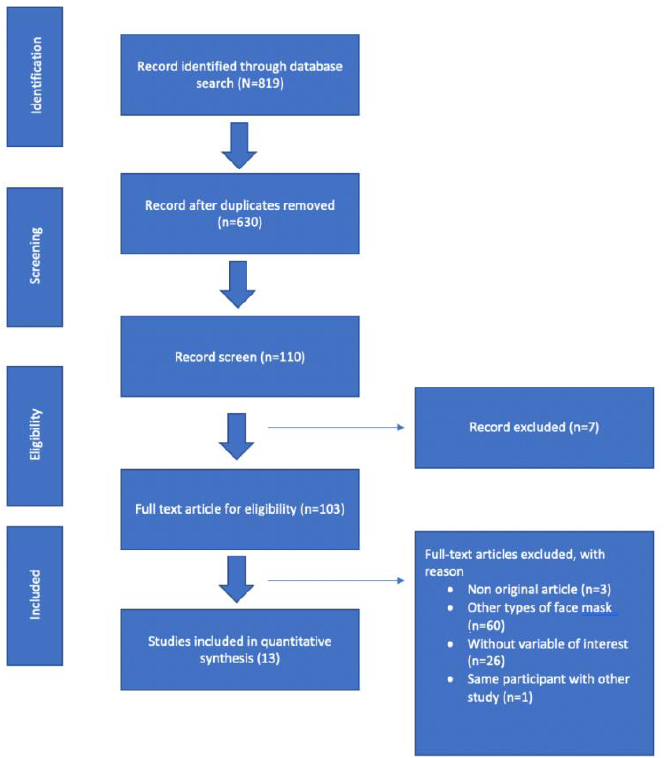
Figure 1. Flow Chart Study Selection Process (PRISMA). N = record identified through database searches; n = recorded data after searches.